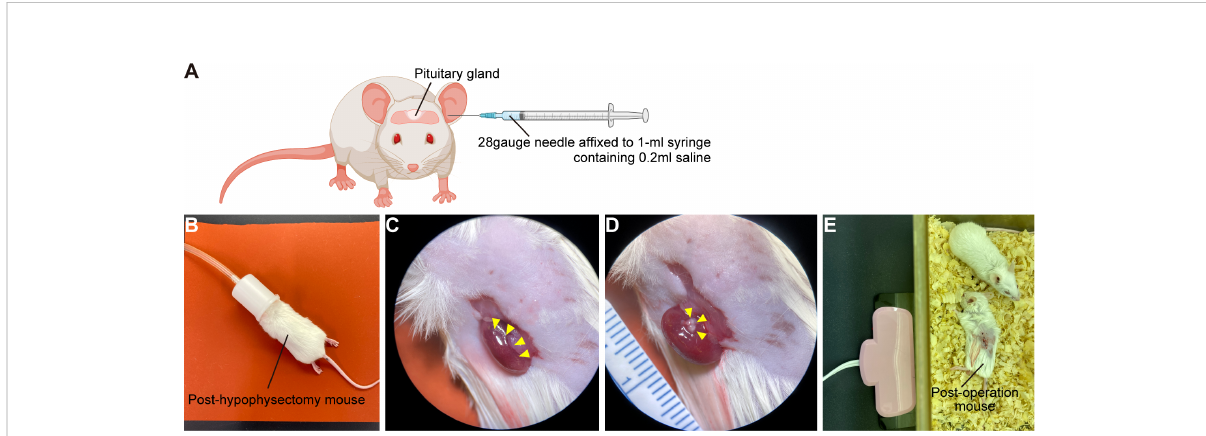
FIGURE 5 Kidney subcapsular transplantation of the hPSC-derived pituitary tissue into post-hypophysectomy mice. (A) Hypophysectomy of SCID mice. Created with BioRender (https://biorender.com). (B) Post-hypophysectomy mice are anaesthetized with iso fl urane. Before the operation, mice are injected with 0.2mg dexamethasone and 2mg ampicillin intramuscularly. (C) Exposure of a kidney (yellow arrowheads). (D) The hPSC- derived pituitary tissue (yellow arrowheads) is transplanted under the renal capsule. (E) Post-transplantation mouse. Mice must be kept